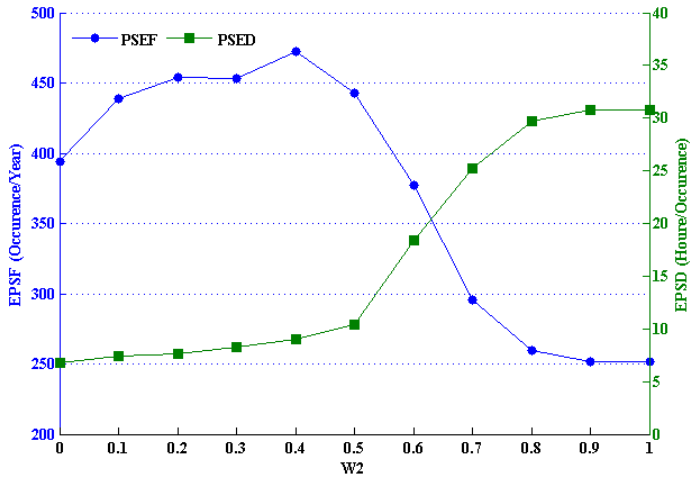
Figure 7. EPSF and EPSD versus the weighting factors.